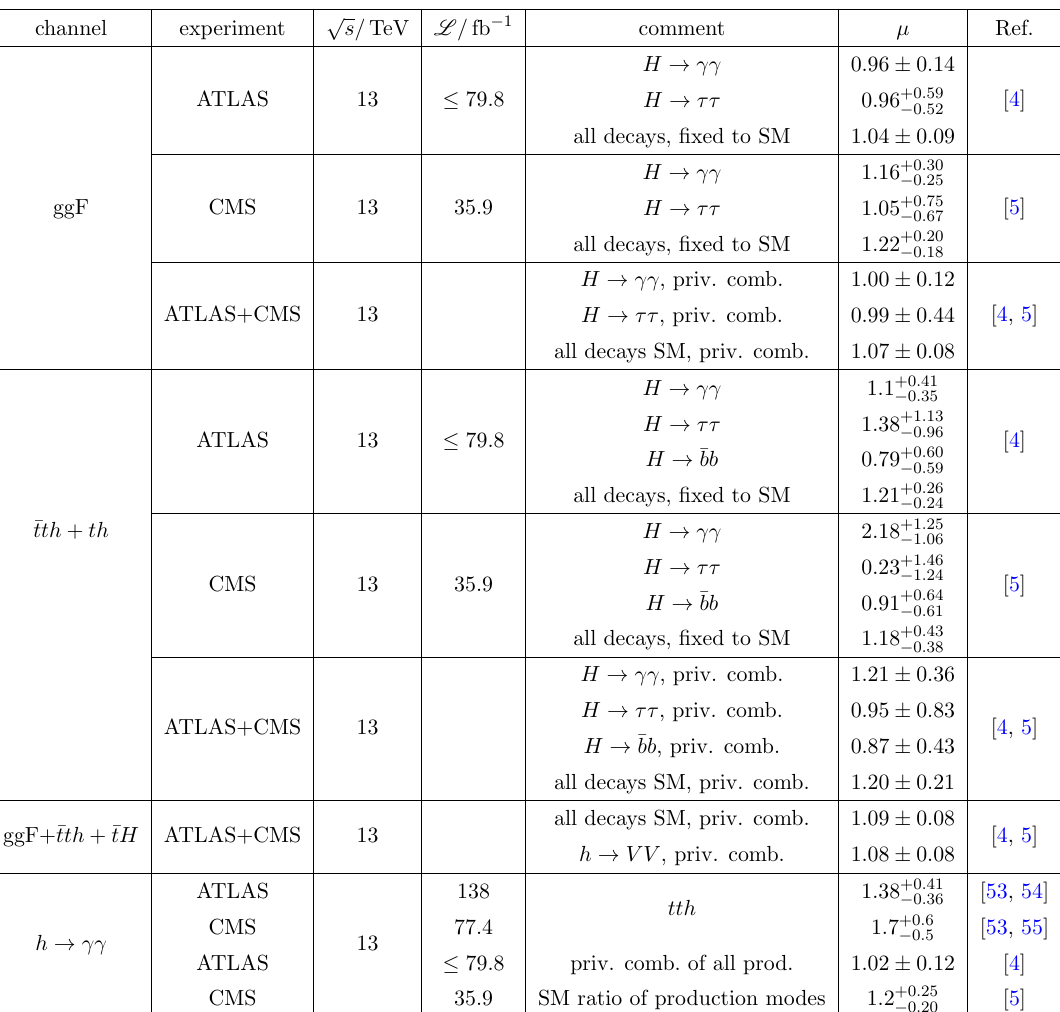
Table 3 . Collider limits on the Higgs signal strengths involving the t . In our private combinations, the uncertainties are approximated as symmetric. The h ! (cid:13)(cid:13) decay does not lead to competitive bounds on T t ; T t R I